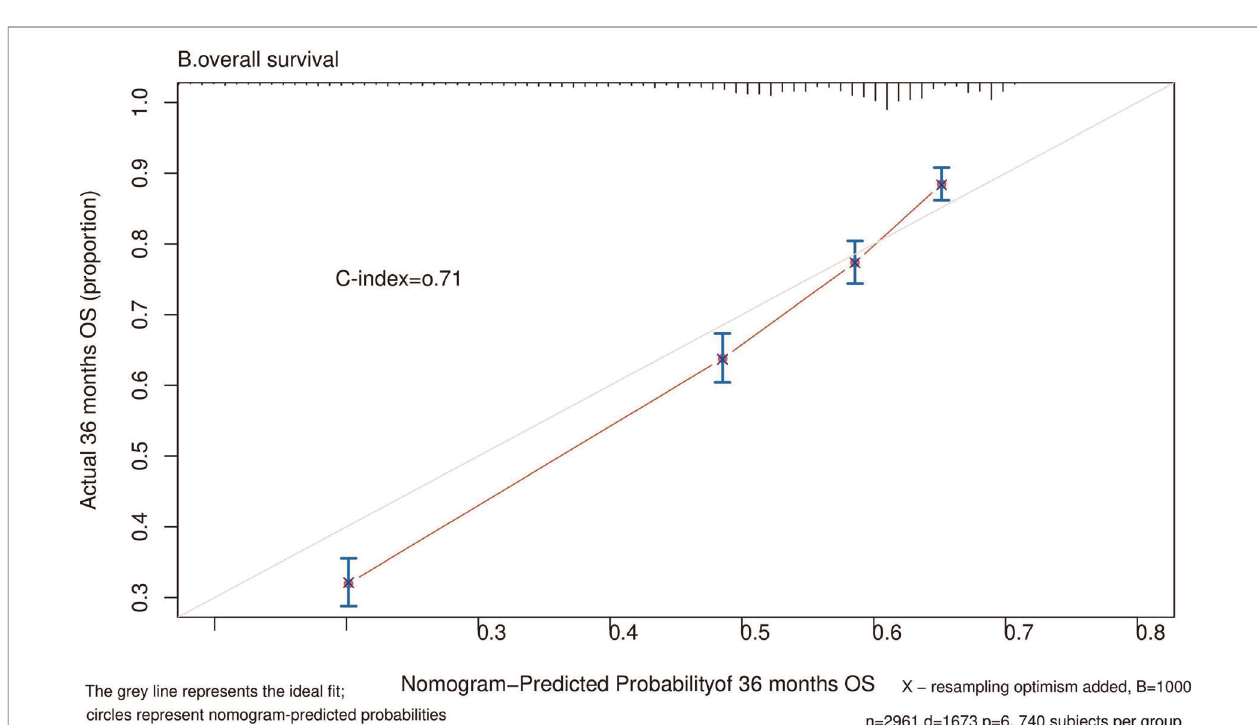
FIGURE 6 | Calibration plot comparing predicted and actual survival probability at 36 months follow-up.